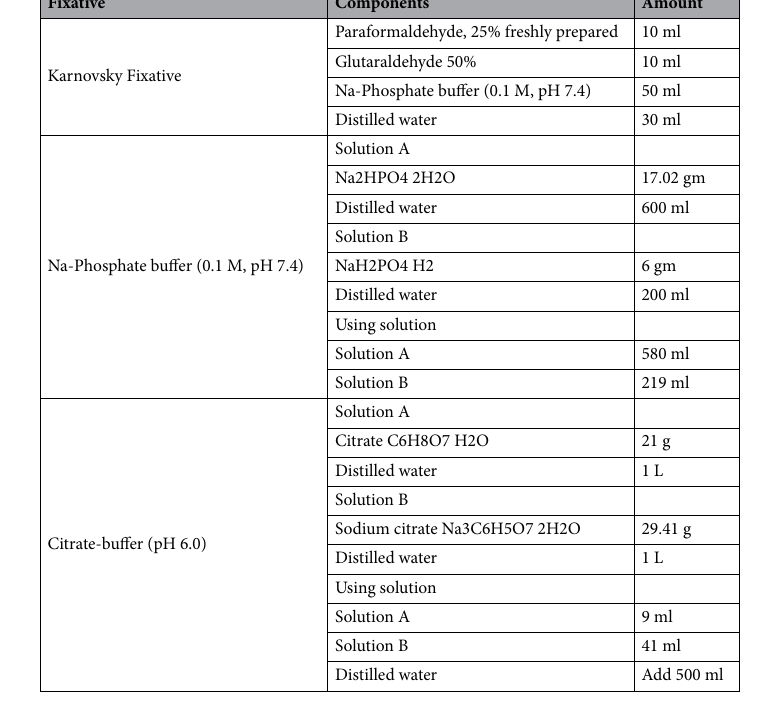
Table 2. Components of the fixative.